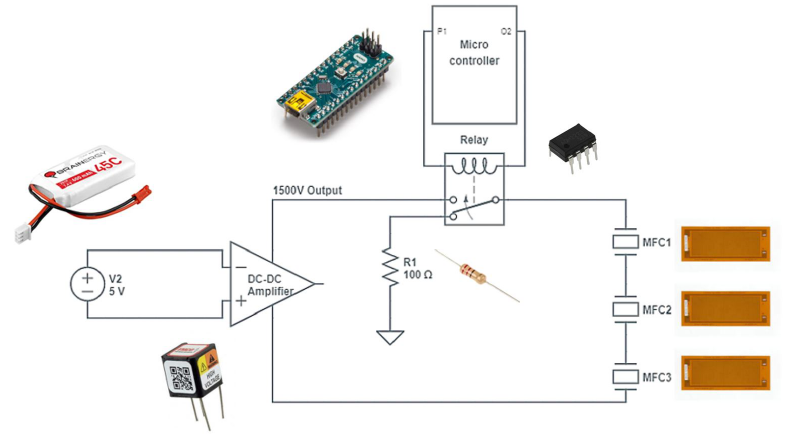
Figure 10. Schematic of the MFC Control Board.